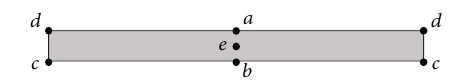
Figure 13: The location of the danger points on thin